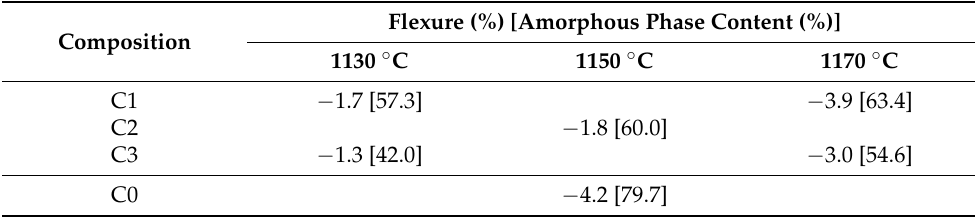
Table 12. Flexure and amorphous phase content (Table 6) of studied compositions at different temperatures.